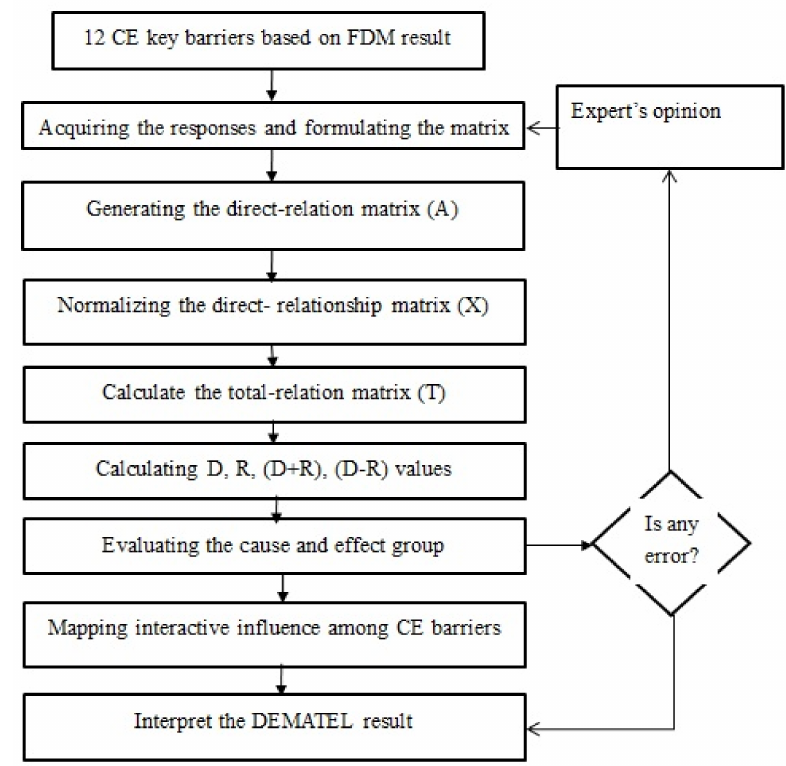
Figure 2. DEMATEL analysis